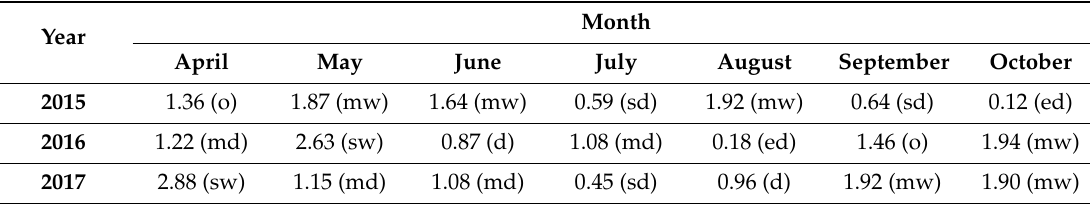
Table 2. Sielianinov’s hydrothermal coe ffi cient